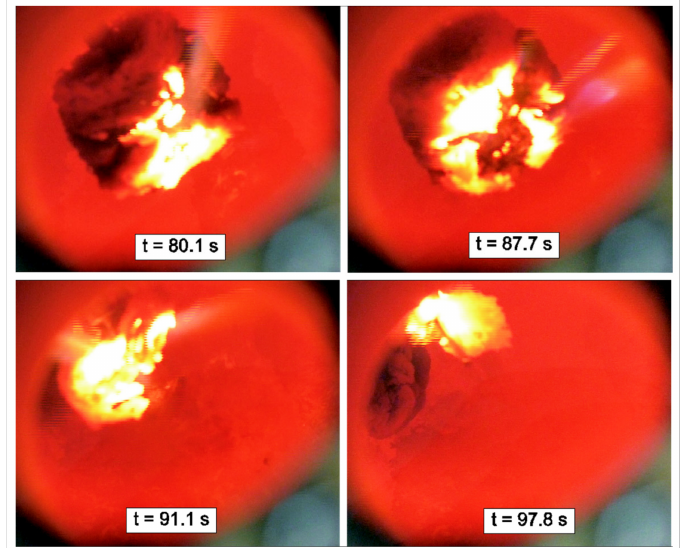
Figure 4. Particle fragmentation.